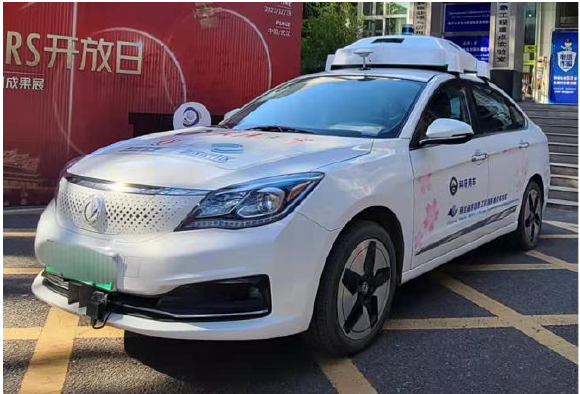
Figure 8 . “Tuyou” autonomous vehicle